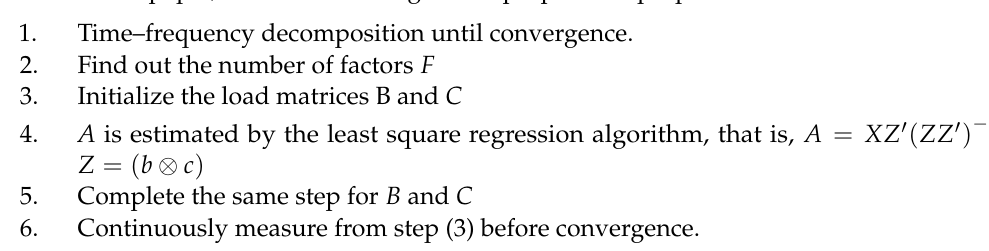
a b c , fk and gk .